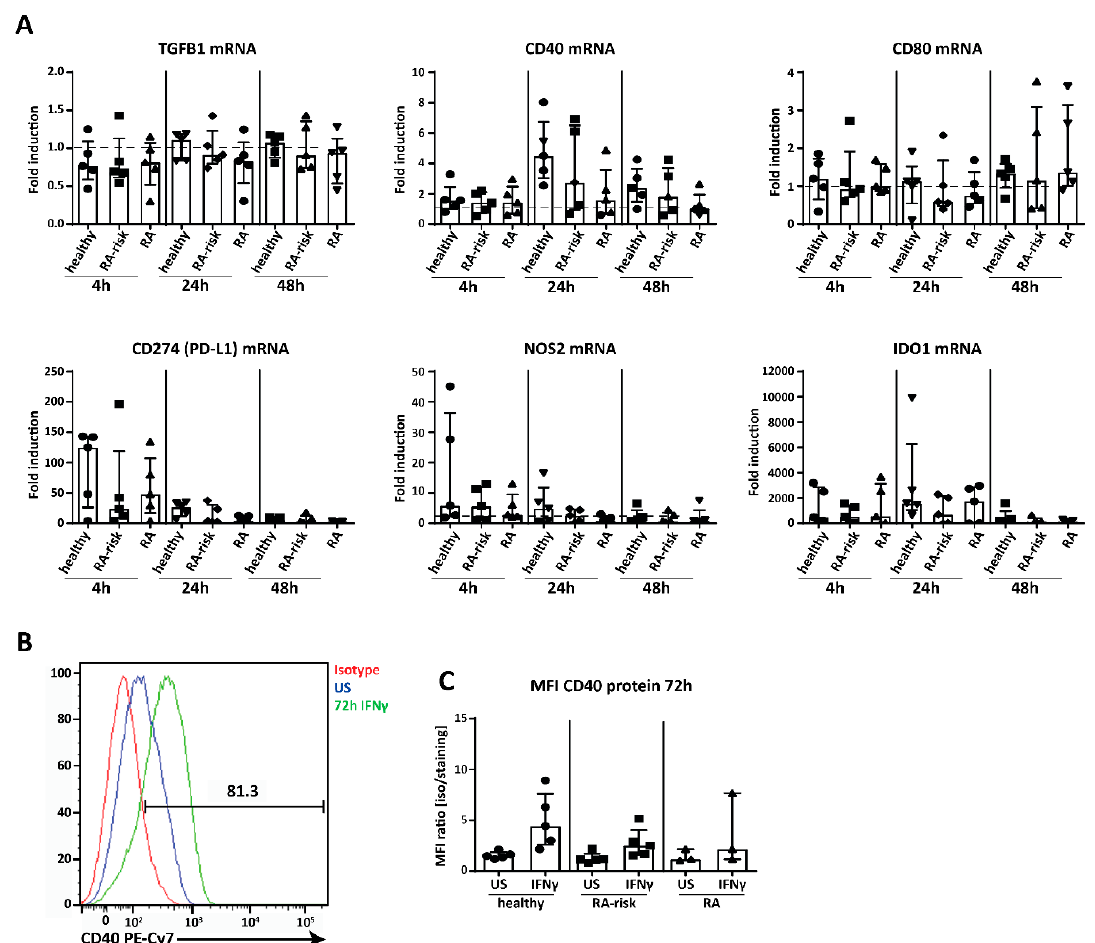
Figure 5. Expression of immunomodulatory molecules in cultured human LNSCs. ( A ) Induction of transforming growth factor beta 1 (TGFB1) CD40, CD80, CD274 (PD-L1; programmed cell death 1 ligand), nitric oxide synthase 2 (NOS2), and indoleamine 2,3-dioxygenase 1 (IDO1) was assessed by qPCR in cultured LNSCs (passages 4–9) after stimulation with IFN γ at different time points (4, 24, and 48 h). Data are represented as fold induction (median with interquartile range) by comparing the mRNA levels in stimulated cells to corresponding unstimulated cells in 15 donors ( n = 5 per donor group). The dotted line represents a fold induction of 1. ( B ) CD40 protein expression was measured by flow cytometry in CD45 − stromal cells. Histogram depicts the increase in staining between isotype, unstimulated and stimulated for 72 h with IFN γ and is displayed for one representative donor (RA-risk individuals passage 8) out of 13 donors tested. ( C ) Induction of CD40 protein upon stimulation with IFN γ for 72 h is further presented as Mean Fluorescent Intensity (MFI) ratio (isotype / staining) in all donors measured (healthy individuals n = 5, RA-risk individuals n = 5, and RA patients n = 3, passages 4–9).